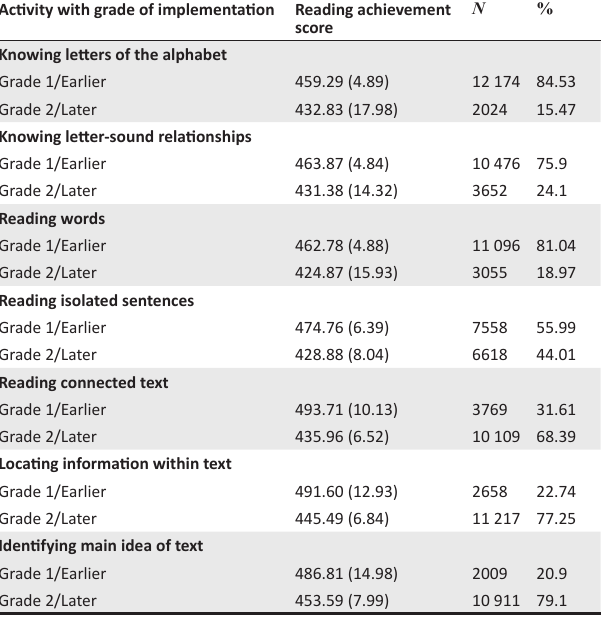
TABLE 4: Reading activities means and percentages based on grade initialised. Activity with grade of implementation Reading achievement score